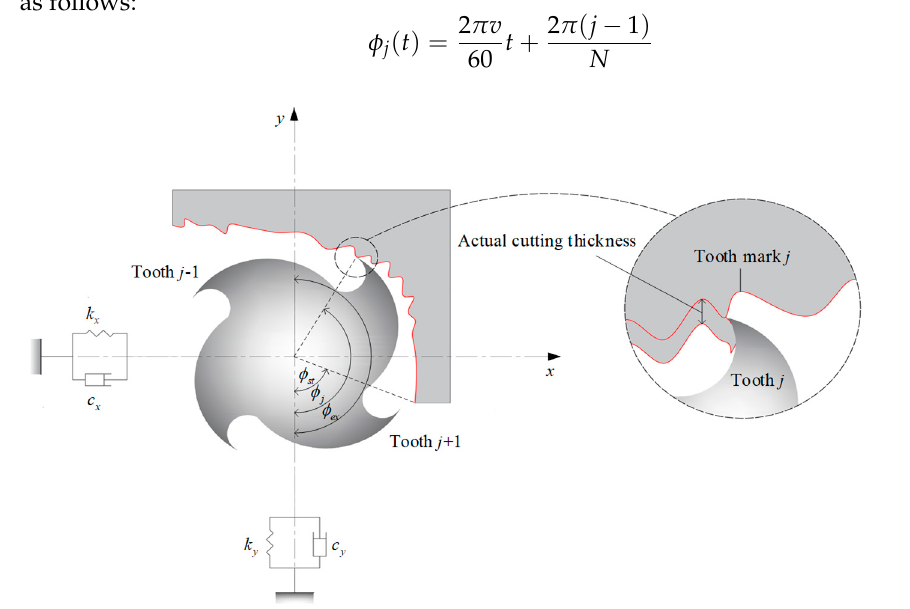
Figure 1. Dynamic system of end-milling with two degrees of freedom.